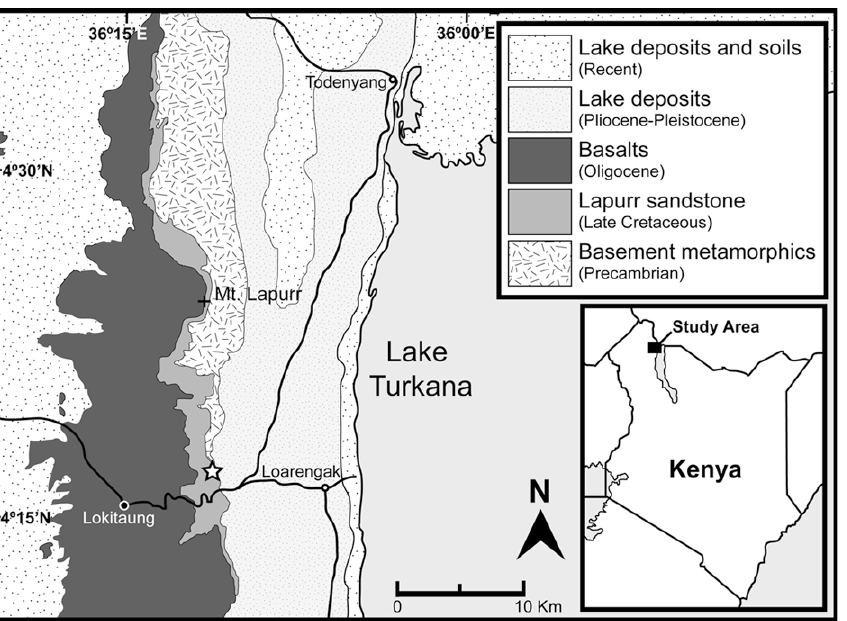
Fig. 1 – Map showing the location of the Lapurr sandstone exposures in northwestern Kenya and the locality (star) from which the pterosaur vertebra here detailed was